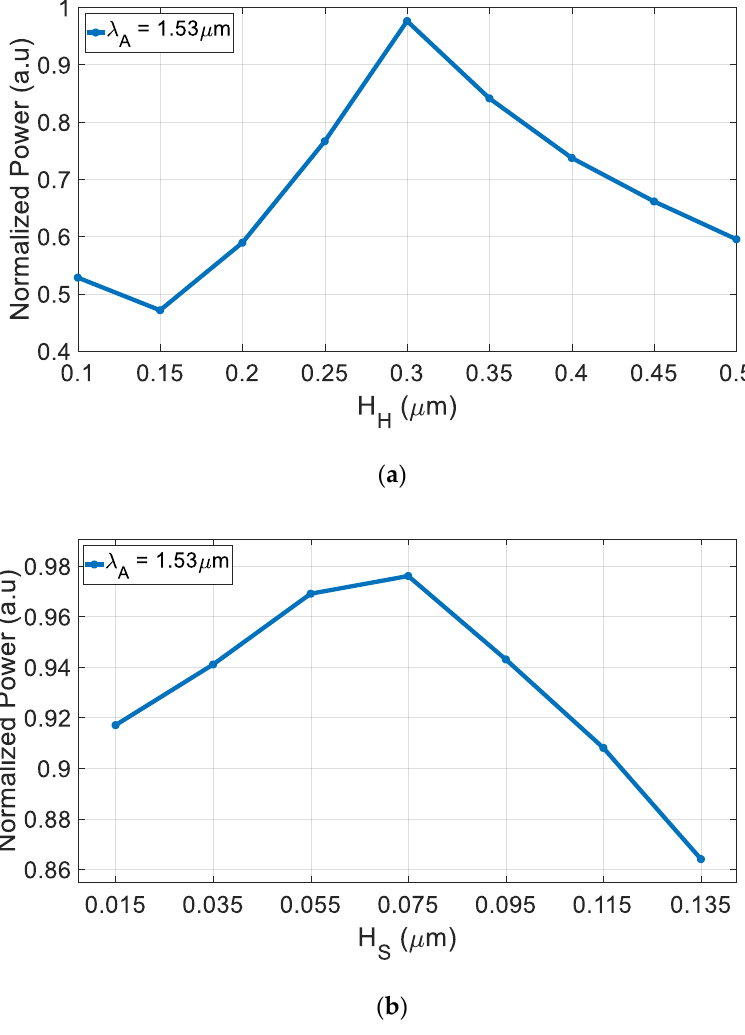
Figure 3. Normalized power as a function of the slot waveguide thickness at 1.53 μm wavelength. ( a ) H H and ( b ) H S